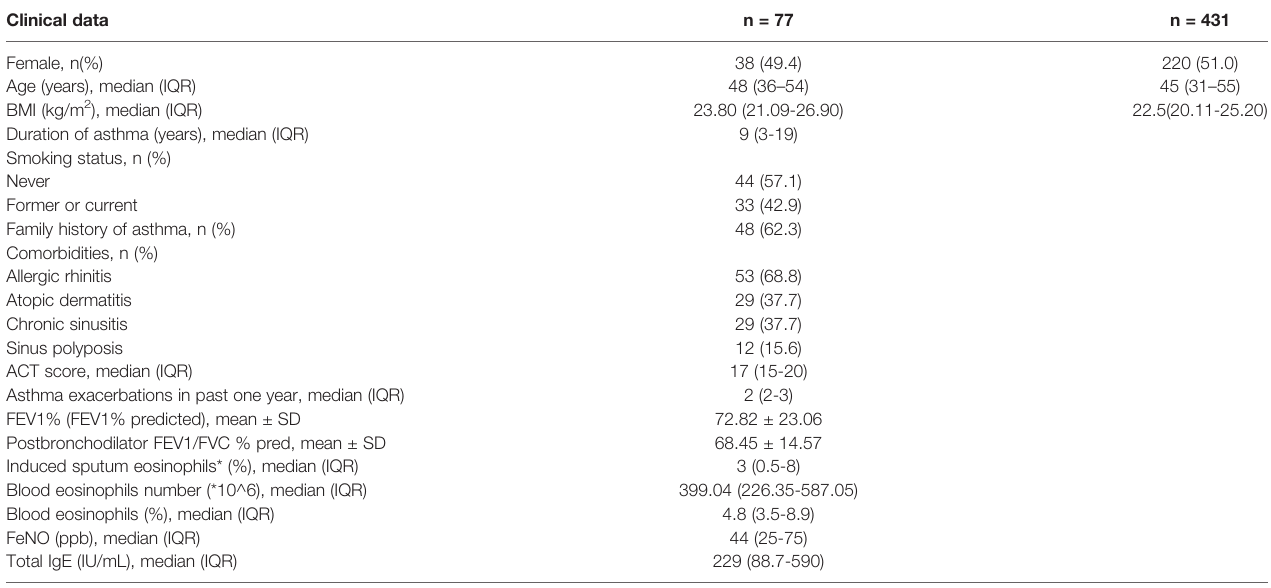
TABLE 1 | The clinical baseline data of EA patients. Clinical